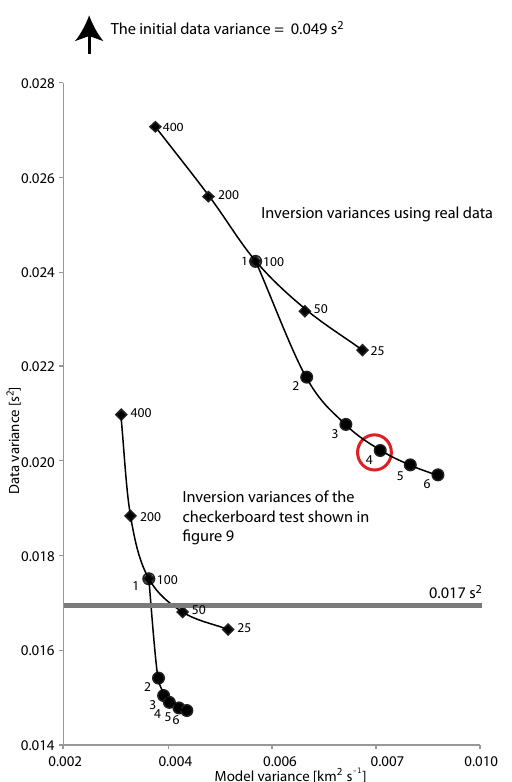
Figure 6. Crustal correction map. Panel (a) shows crustal correction values for all of the stations. The values are based on a travel time of a vertical seismic ray travelling through the crustal correction model described in Sect. 4.2. Panel (b) shows the comparison of the travel times through a vertical section of the pseudo-3-D crustal correction model used in this study (black line) and the southern part of the POLAR wide-angle reflection and refraction profile (red line, Janik et al., 2009). The location of the comparison is shown by a black line in (a)